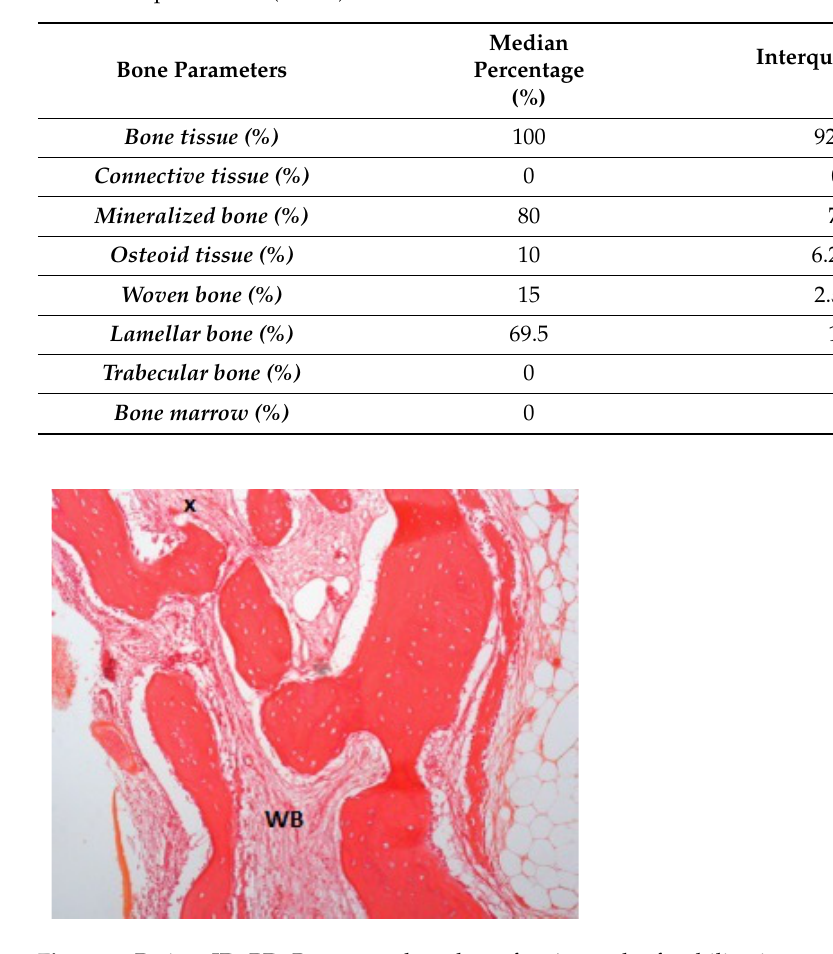
Table 2. Median percentages of the osseous parameters, and in parentheses, the interquartile range of the bone parameters ( n = 12).